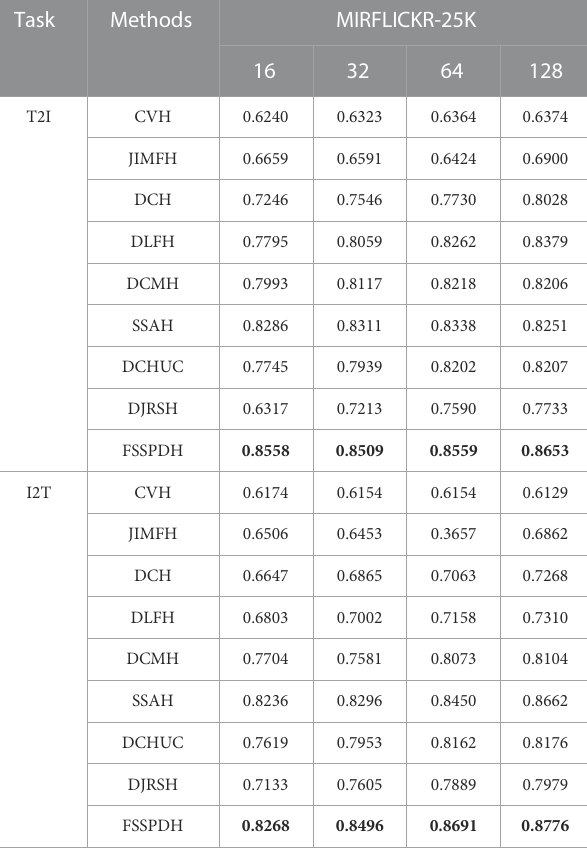
TABLE 3 The MAP values of cross-modal retrieval on NUSWIDE dataset.